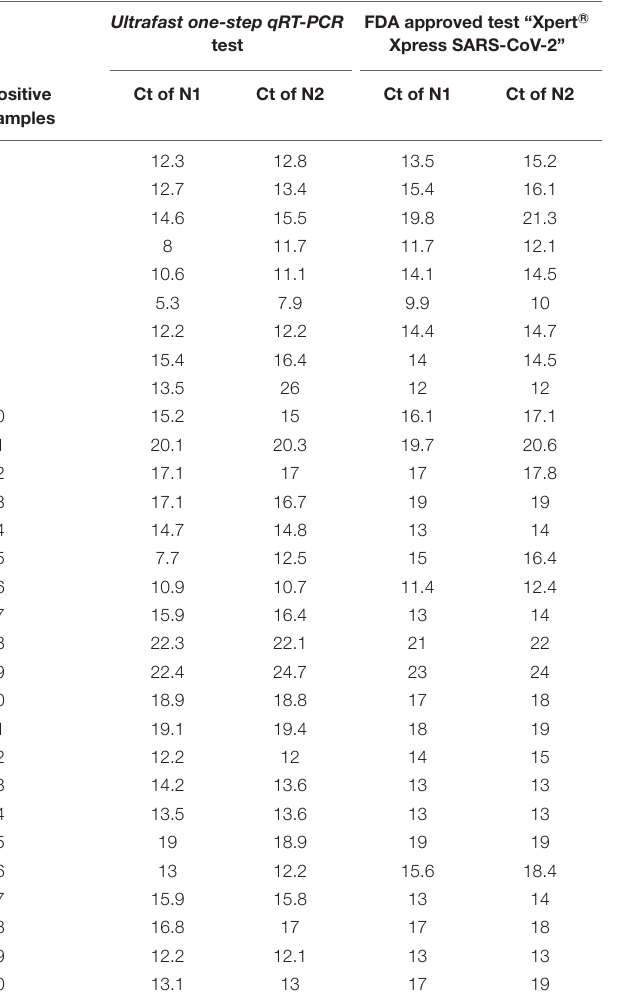
TABLE 5 | Positive and negative predictive values of ultrafast one-step qRT-PCR for SARS-CoV-2 detection in nasopharyngeal samples.